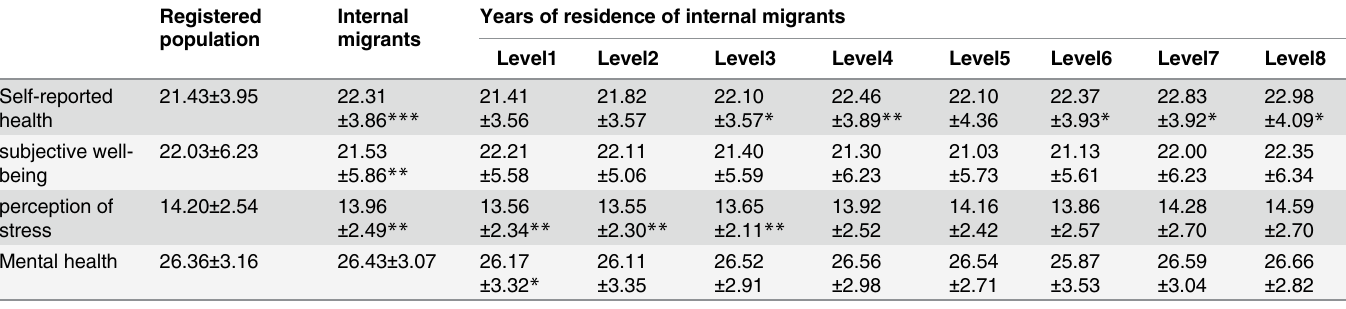
Table 4. Respondent ’ s health situation in 2014 in ZhongShan (  x  ±